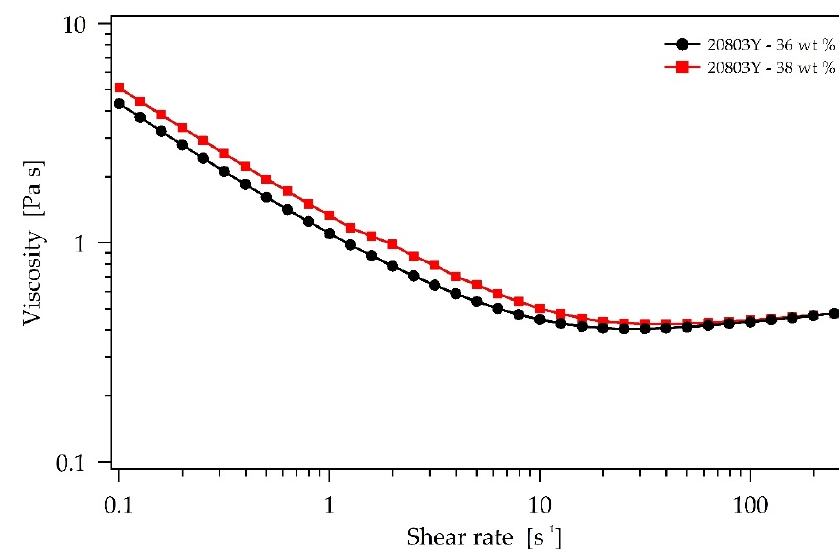
Figure 5. Photocurable slurry viscosity.